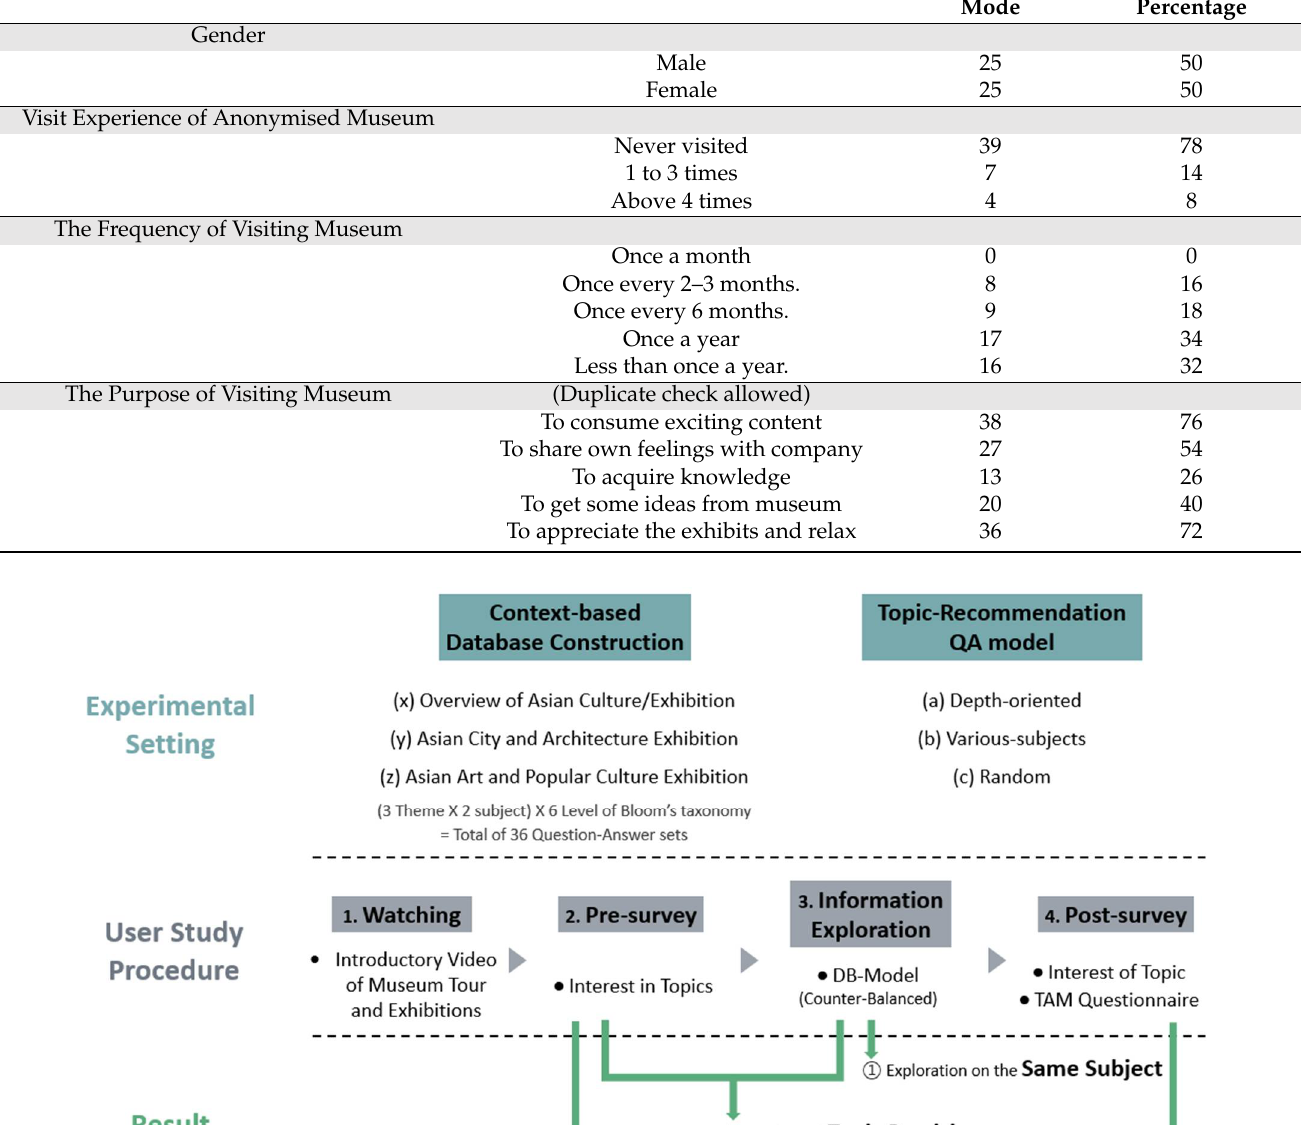
Table 1. Participants’ demographic and background information.